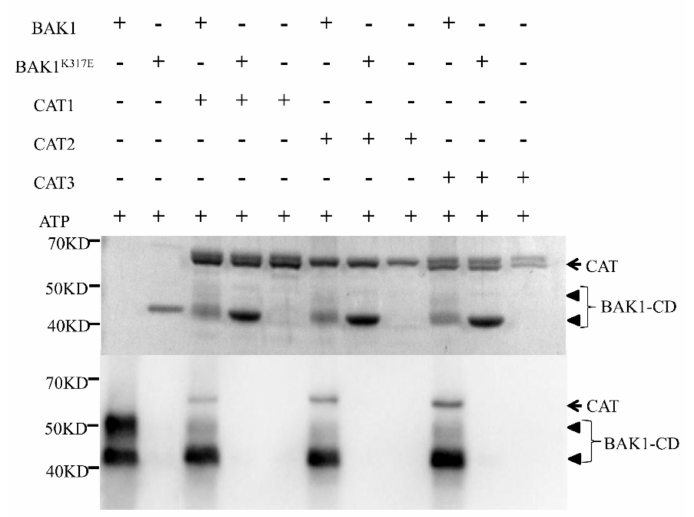
Figure 5. BAK1 can phosphorylate CATs in vitro. The Flag-BAK1-CD (CD, cytoplasmic domain), Flag-BAK1 K317E -CD, and Flag-CAT1 / 2 / 3 constructs were expressed in E. coli BL21 and the recombinant proteins were purified using anti-Flag a ffi nity gel. In vitro phosphorylation reaction was carried out using appropriate recombinant proteins and separated by SDS-PAGE. Coomassie blue-stained recombinant BAK1-CD, BAK1 K317E -CD, and CAT1 / 2 / 3 proteins are shown in the top panel. The phosphorylation assay is shown in the bottom panel. The arrowhead shows BAK1 and the arrow shows CAT1 / 2 / 3 proteins. The phosphorylation of CAT1 / 2 / 3 could be detected after it reacted with BAK1-CD. The experiments were repeated three times with similar